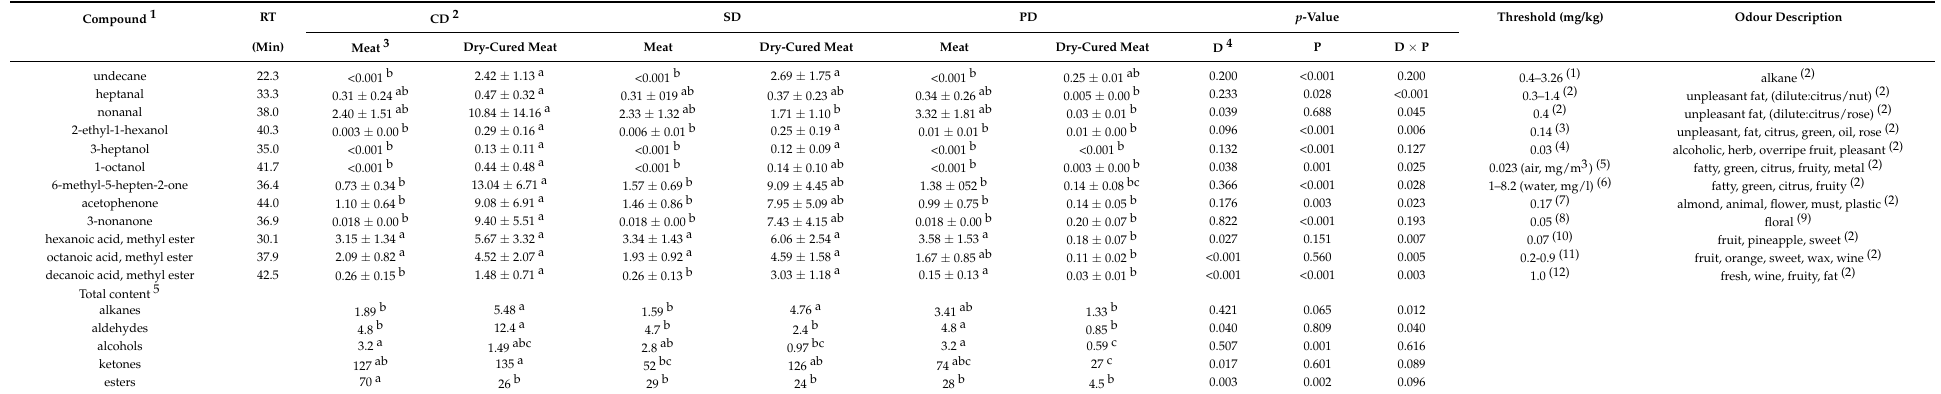
Table 4. Differences in volatile compounds ( p < 0.05) between raw meat and dry-cured leg from lamb fed three finishing diets. Results are presented as mean ± STD ( n =